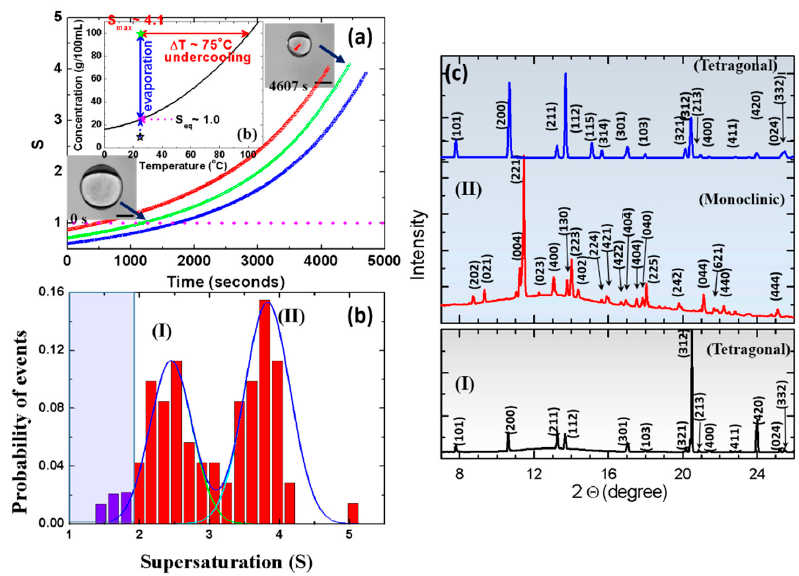
Figure 3. Increasing degree of supersaturation of the KH 2 PO 4 (KDP) solution with time by evaporation process at room temperature ( a ) [4]. The saturation curves represent experimental trials that were performed with different initial concentrations (blue, 15 g/100 mL; green, 18 g/100 mL; red, 22 g/100 mL). Inset figure shows the state of metastability of the KDP droplet at s = 4.1 is equivalent to undercooling from 100 °C. The scale bar in the droplet images is 1 mm. Probability of crystallization events with supersaturation ( b ) [4]. Formation of stable (I) and metastable (II) phases of the KDP crystal from the supersaturated solution depends on the supersaturation, in which crystallizations took place ( c ) [4]. As shown in the upper panel of (II) in figure (c), the monoclinic KDP phases finally transforms into the stable tetragonal KDP crystal after 30 min to 1 h during the levitation, which indicates that the monoclinic KDP is metastable. The diffraction intensity difference of tetragonal phases in figure (c) resulted from directional crystal growth at the initial stage of the crystallization (I). The estimated interfacial free energy for the stable KDP crystal at s = 3 is 34.5 mJ/m 2 based on Equation (2). This value is significantly greater than any other results previously reported